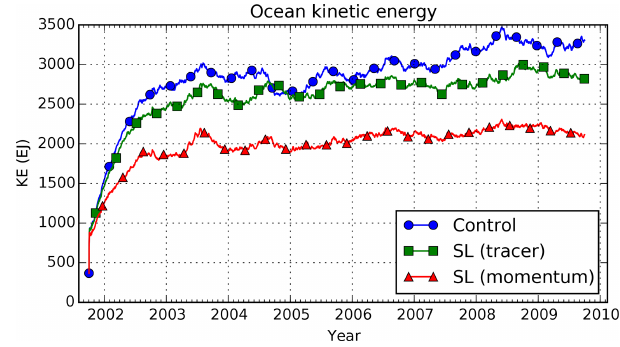
Figure 9. (a) Initial ocean-average temperature profile ( ◦ C) vs. depth and (b) change at the end of the simulated period (4 Octo- ber 2009) for the test cases of Sect. 5.2. Both semi-Lagrangian runs show temperature stability in deeper waters, whereas the control run shows a small cooling.